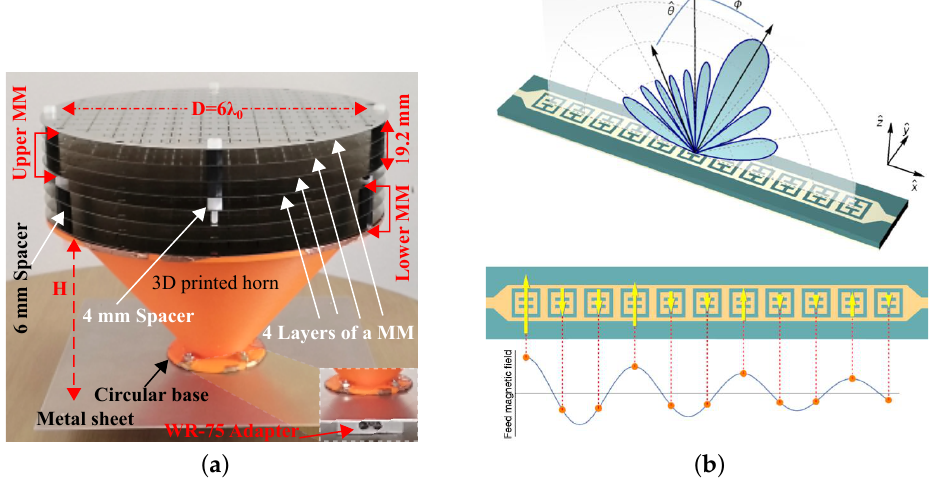
Figure 4. Metasurface-based beam-steering antennas. ( a ) 2D beam-steering antenna system driven by a pair of metallic metasurfaces [31]. ( b ) Metasurface antenna and illustration of the excitation by the feed wave